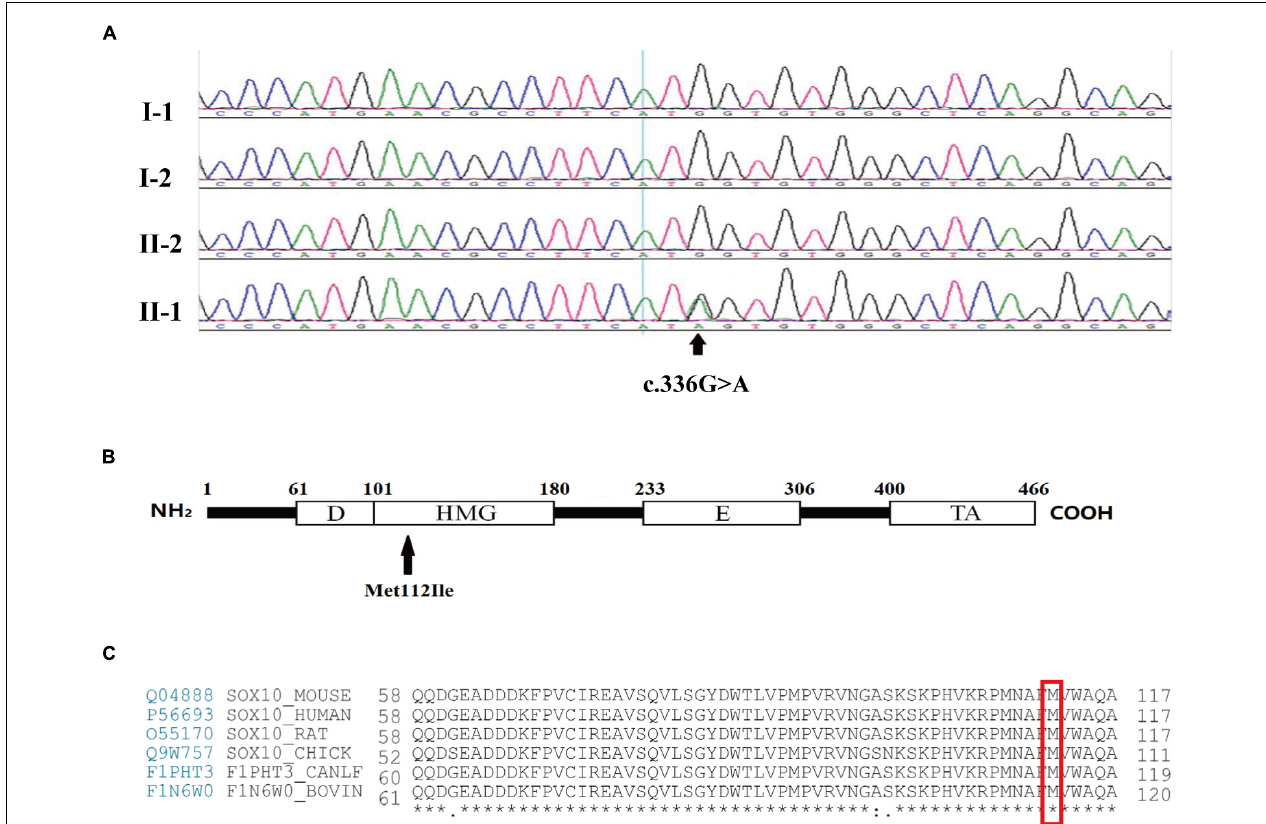
FIGURE 2 | Mutation analysis and amino acid coding diagram. (A) DNA sequencing profile revealed that the SOX10 mutation c.336G > A (p.Met112Ile) was found in the proband (II-1) and not in his father (I-1), mother (I-2), or brother (II-2). The arrow indicates the area of the base substitution. (B) Schematic diagram of the SOX10 gene. The black arrow indicates the mutation site. D, Dimerization domain; HMG, high mobility group domain; E, Conserved domain of SOX8/9/10; TA transactivation domain. (C) Protein sequence alignment of vertebrate SOX10 ; note the highly conserved Met112 residues across various species. * represents the same amino acid at the same site among different